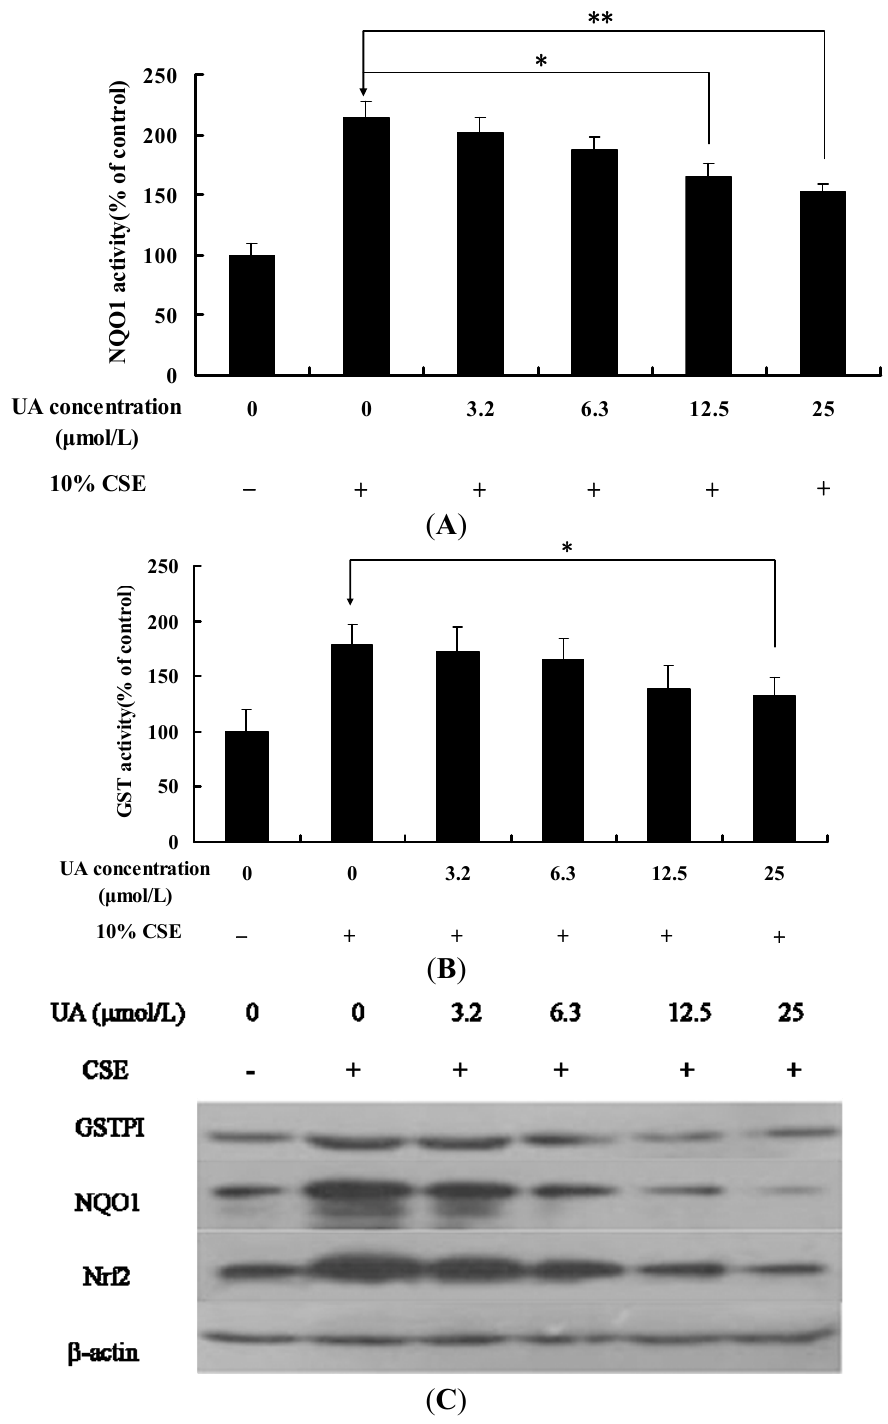
Figure 3. Effect of UA on the activity of phase II enzymes ( A ) NQO1 and ( B ) GST and ( C ) the expression of Nrf2, NQO1, and GSTPI in NHBE cells. * p < 0.05, ** p < 0.01 vs . CSE group.